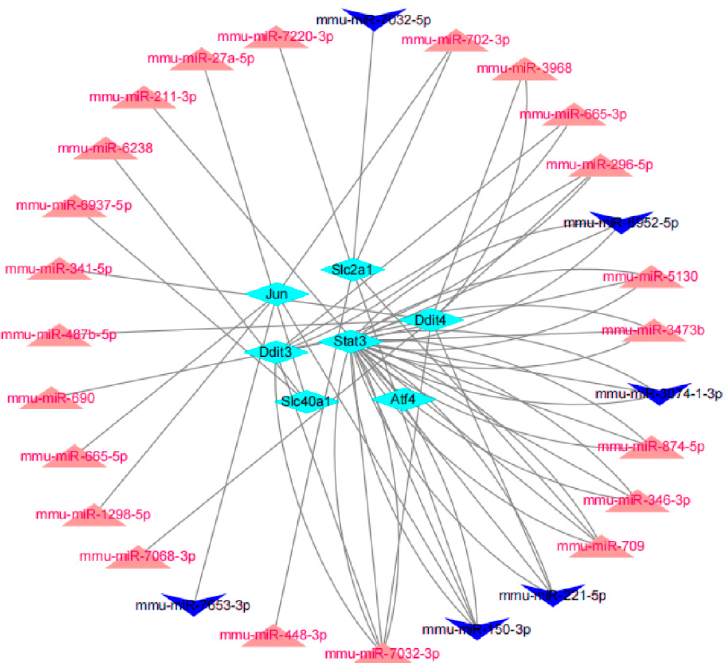
Figure 6. The regulatory network of the optimal hub FRDEGs-miRNA. Red represents up-regulated miRNA, blue represents down-regulated miRNA, and turquoise represents the optimal hub FRDEGs.